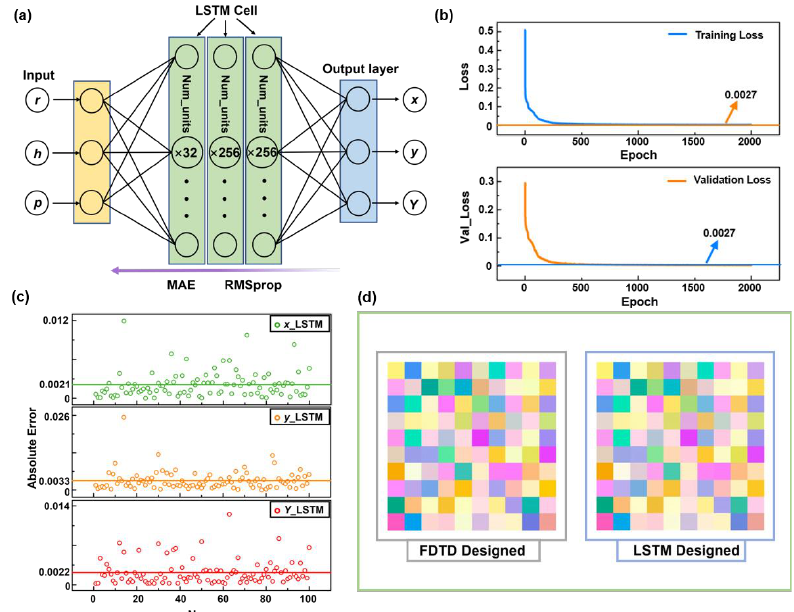
Figure 4. ( a ) Schematic of the LSTM for predicting Si structural colors. ( b ) The loss function of training loss and validation loss in the LSTM training process. ( c ) The absolute error between 100 groups of calculated color values and LSTM predicted color values. ( d ) Comparison between 100 groups of real color and predicted color display.